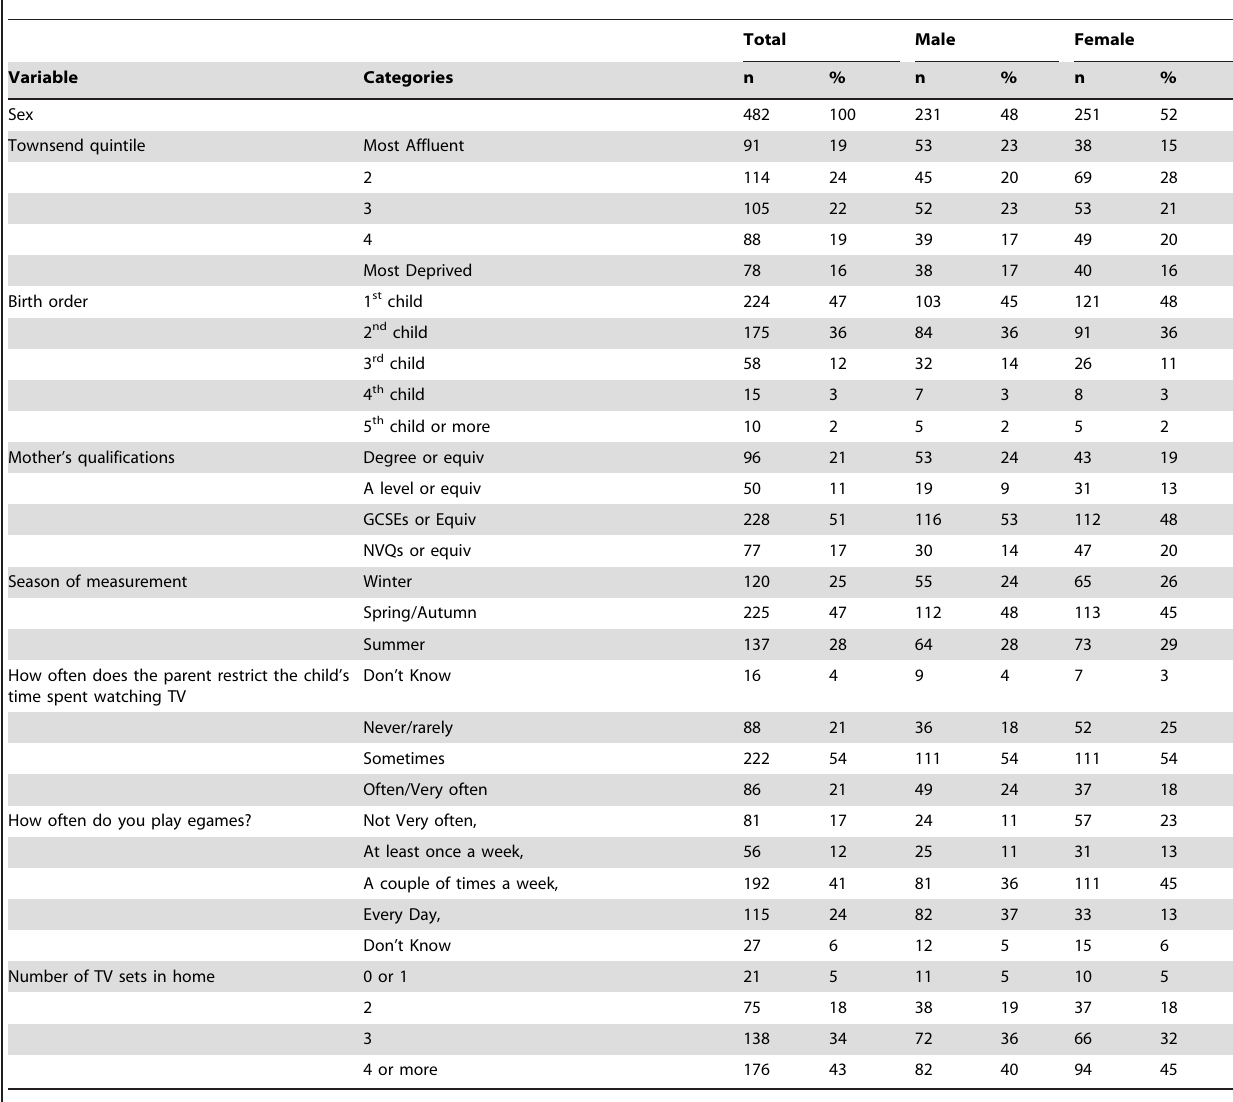
Table 2. Descriptive statistics, by sex, for categorical